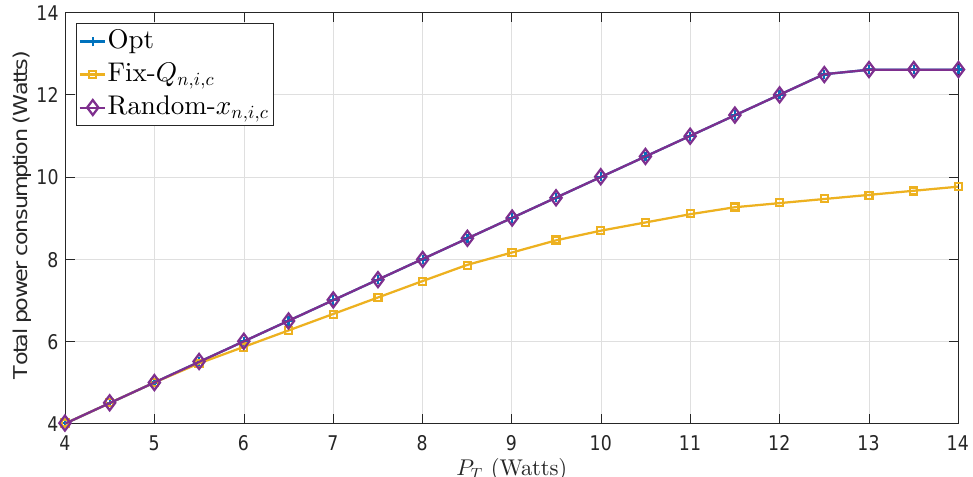
Figure 3. P T VS power consumption of all the considered techniques.